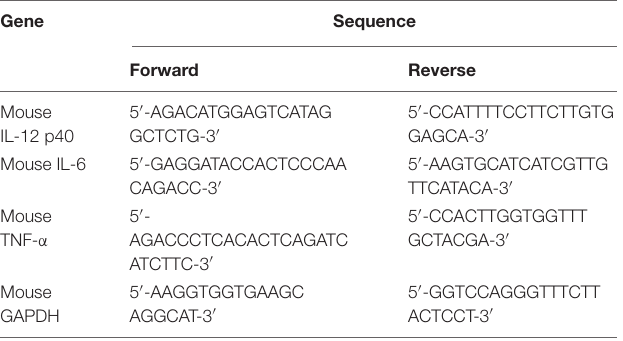
TABLE 1 | Real-time PCR primer